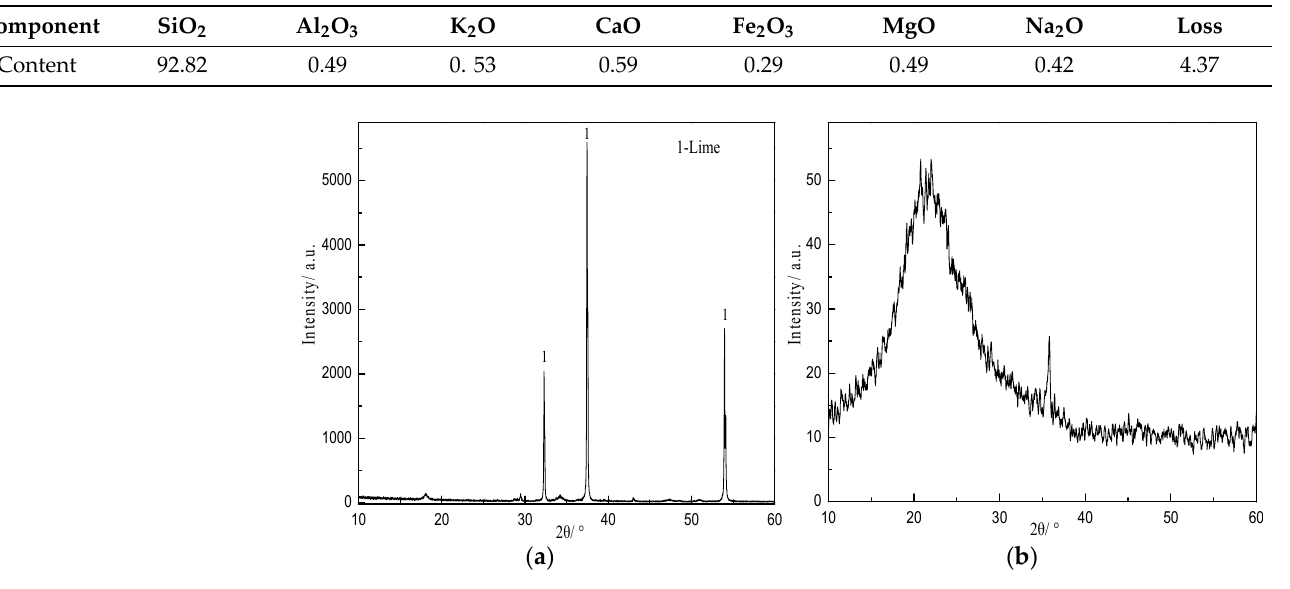
Table 1. Chemical composition of silica fume (wt%).